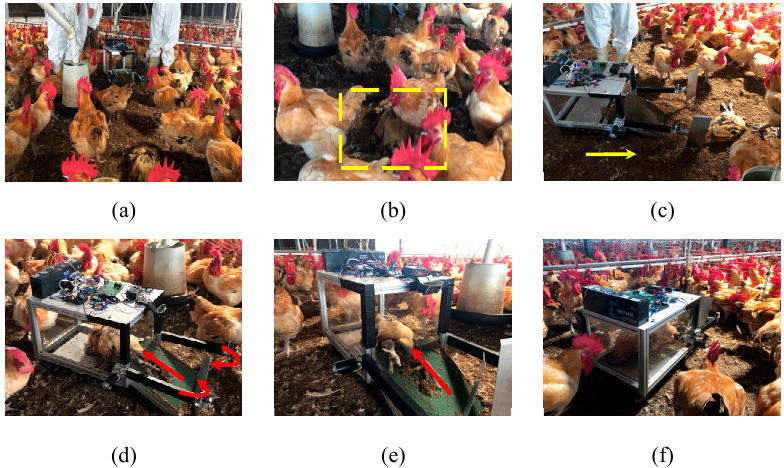
Figure 13. ( a ) Process of the developed system, ( b ) the identification of dead chickens, ( c ) inputting the command of the tracked vehicle, ( d ) inputting the commands of the conveyor belt and robot arms, ( e ) the movement of a dead chicken to the cache storage, and ( f ) the complete removal task.